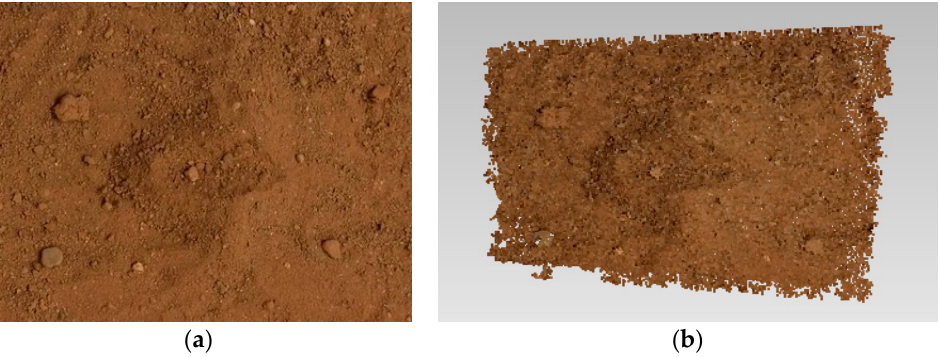
Figure 4. The reconstructed dense point cloud of the collection area. ( a ) Collection area image; ( b ) Reconstruction effect of the corresponding